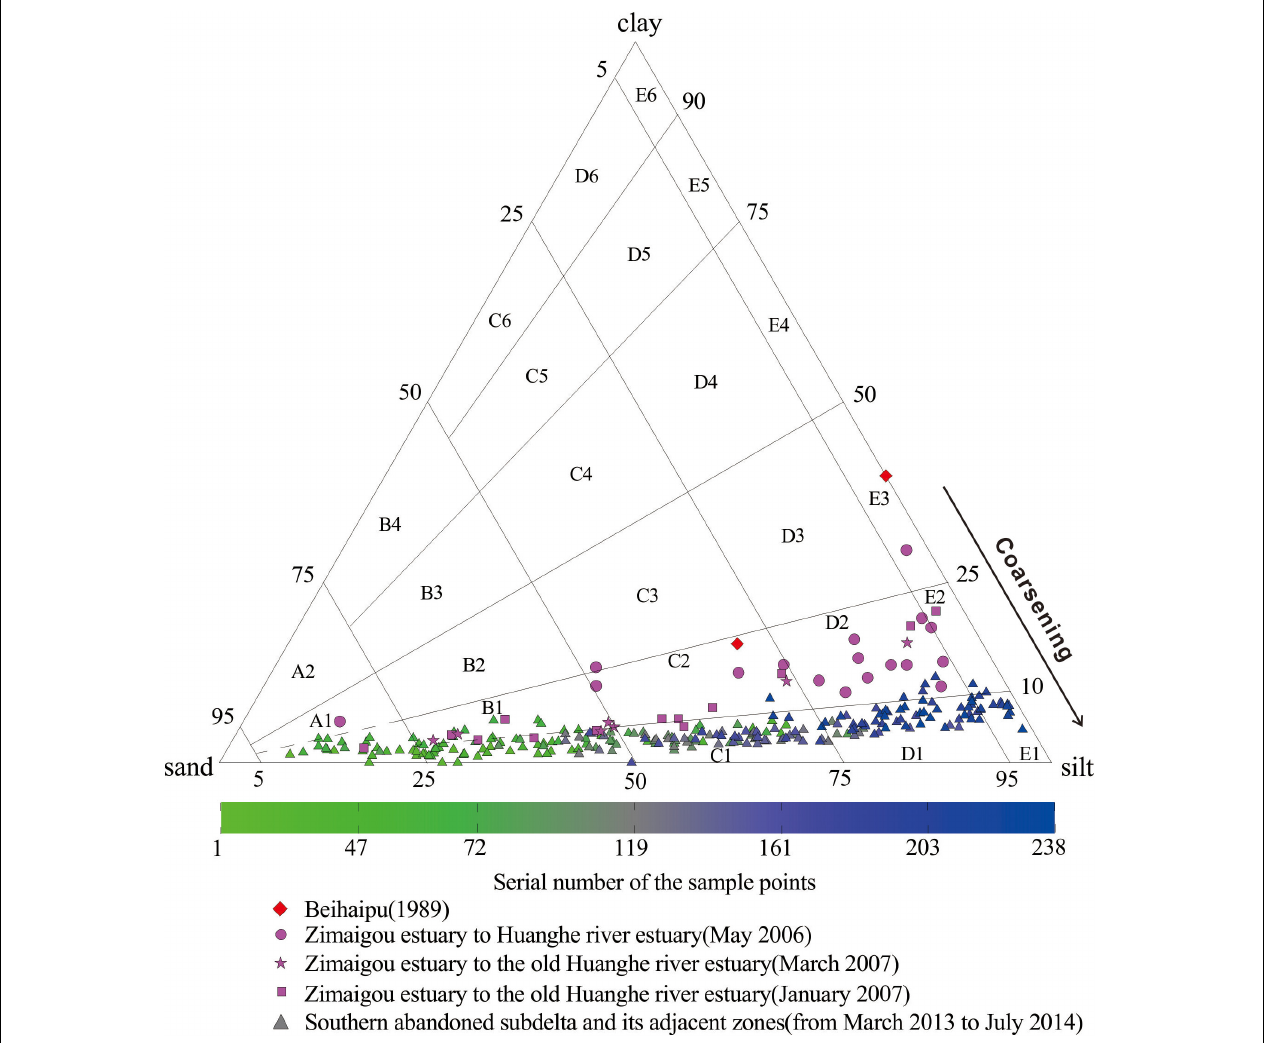
FIGURE 4 | Ternary diagrams based on sand/silt/clay ratios illustrating textural trends observed in the tidal flats of the southern abandoned sub-delta of the Yellow River and adjacent zones. The grain-size composition data from Beihaipu and the zones from the Zimaigou estuary to the Yellow River estuary are collected from Li et al. (1991), Xing (2007), Liu et al. (2010), and Chen and Huang (2014).